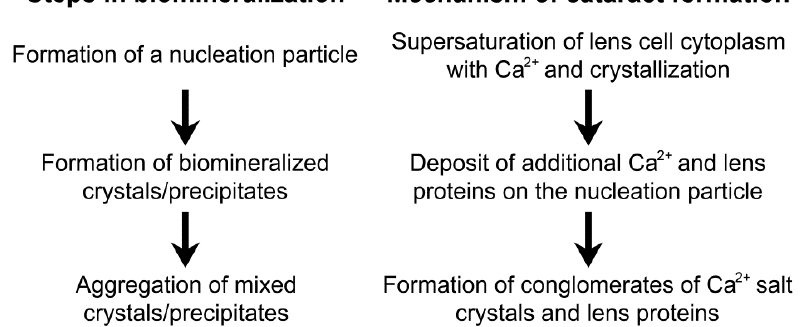
Figure 5. The proposed mechanism by which calcium ions contribute to cataract formation through biomineralization. Lenses from mice with disruptions of the lens circulation due to mutations of Cx46 or Cx50 accumulate Ca 2+ . When the K sp for calcium salts is surpassed, the salts precipitate and act as a nucleation particle. Then, more calcium salts and lens proteins deposit over the nucleation particle. With time, this leads to the formation of an aggregate containing a mix of calcium salts and lens proteins, i.e., a deposit of biomineral.